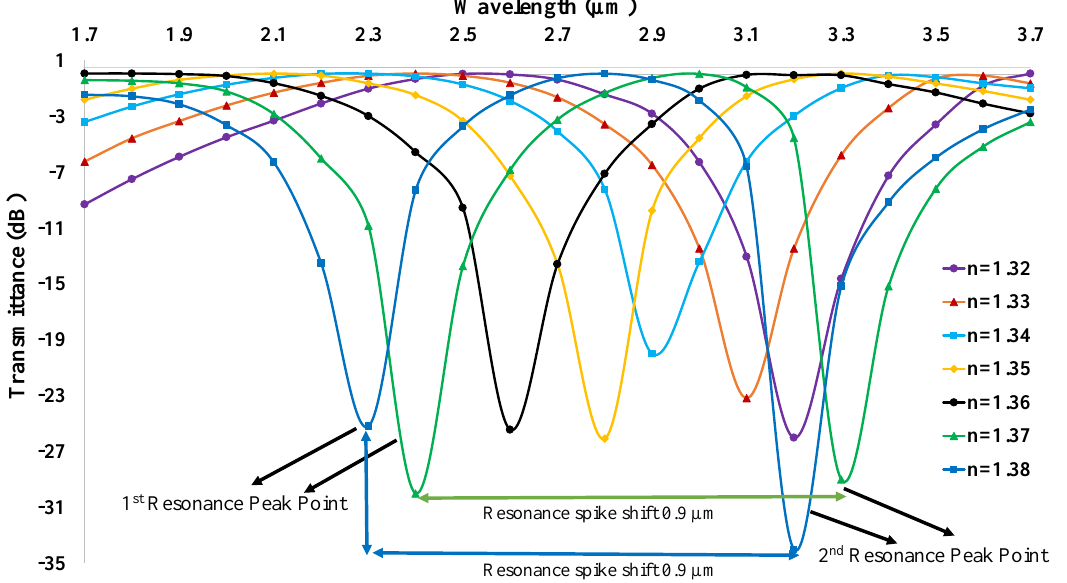
Figure 6. Transmittance variations in dB scale of the proposed C − PCF versus